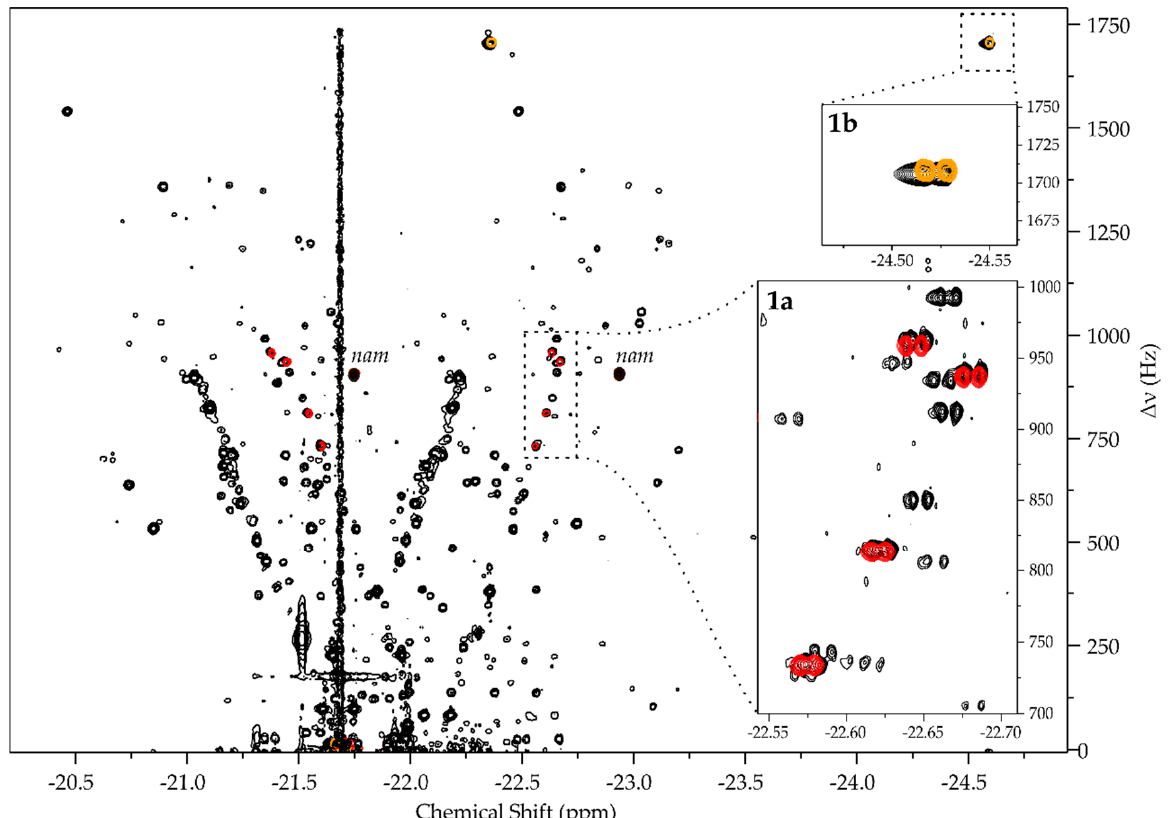
Figure 3. Hyperpolarized 2D ZQ spectrum of urine SPE extract overlayed with spectra of ( 1a ) (red) and ( 1b ) (beige), referenced to nam signal (using − 22.935 ppm for right hand hydride signal [6]). All hydride signals of the same analyte are presented in the same color, although the doublet pairs are detected in opposite phase [6].